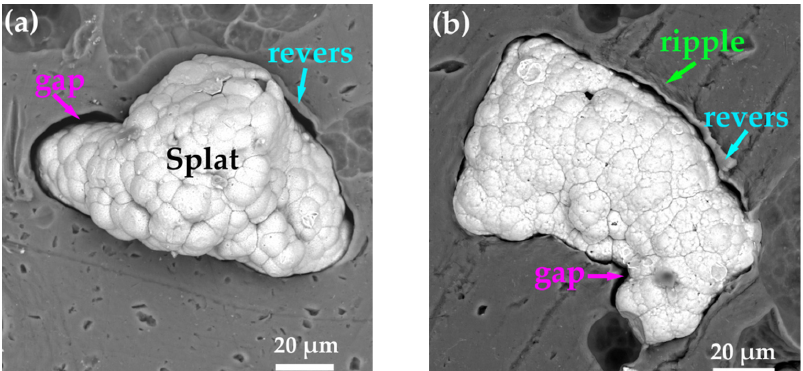
Figure 4. Surface morphologies of Ni-coated Al splat deposited onto the Al substrate at an accelerating gas temperature of ( a ) 200 °C and ( b ) 400 °C.